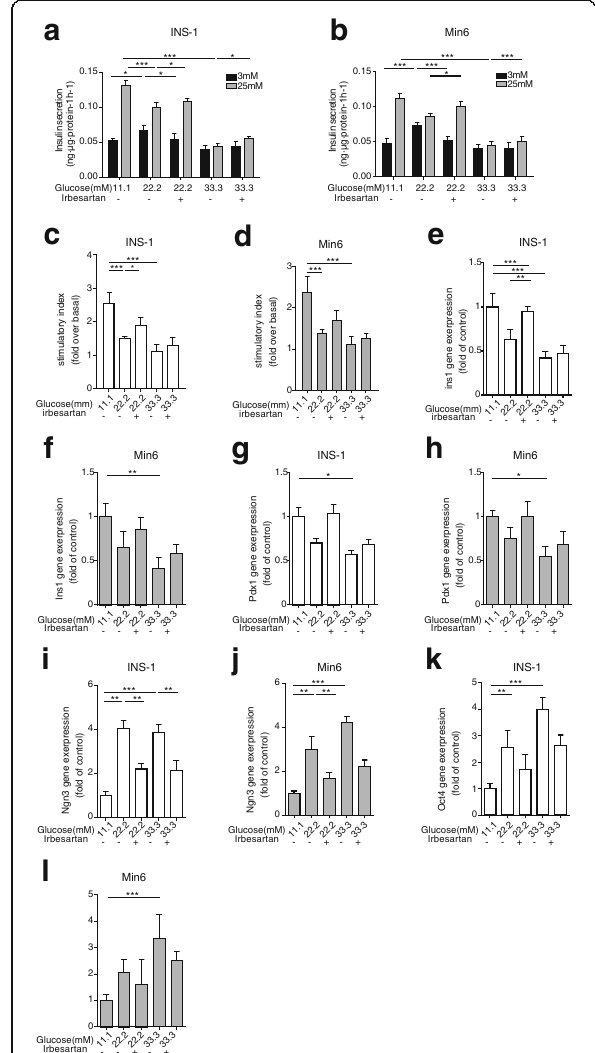
Fig. 1 RAS inhibition reverses glucotoxicity-induced compromised β - cell identity. Pancreatic β cell lines were cultured with increasing concentrations of glucose in the presence or absence of irbesartan (IRB, 10 μ mol/L) for 24 h. Performing ( a, b ) a GSIS assay to determine ( c, d ) the stimulatory index in Min6 cells and INS-1 cells. qRT-PCR analyses for markers of ( e-h ) β cell identity genes ( Ins1 , Pdx1 ), and ( i-l ) progenitor like cells markers ( Ngn3 , Oct4 ) in β cells. Data are presented as the mean±SEM of three independent experiments ( n =6). * p <0.05, ** p <0.01, *** p <0.001, one-way